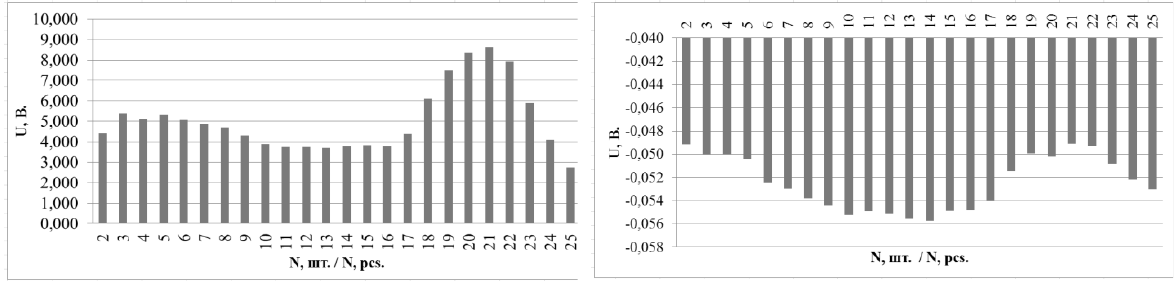
Fig. 16. A mean square deviation of signals from sensors depending on N – quantity of elements of an inertial body (averaging on the next